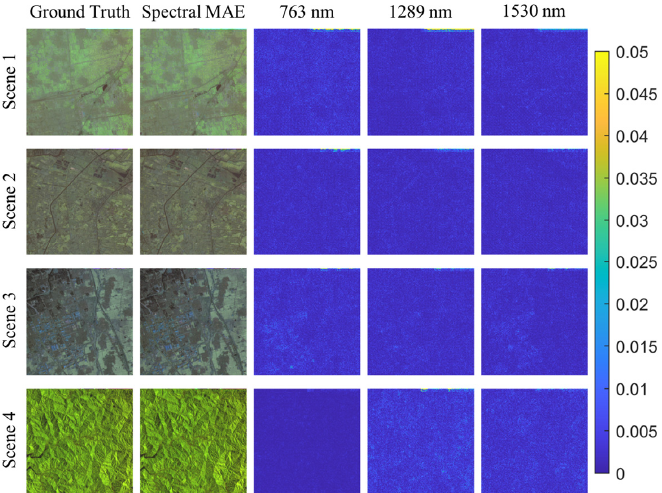
Figure 9. Visualization of the error maps between ground truth and the reconstructed results of SpectralMAE on the GF2Hyper dataset with only three channel inputs. The second column is the synthesized RGB image of the reconstructed spectral image.